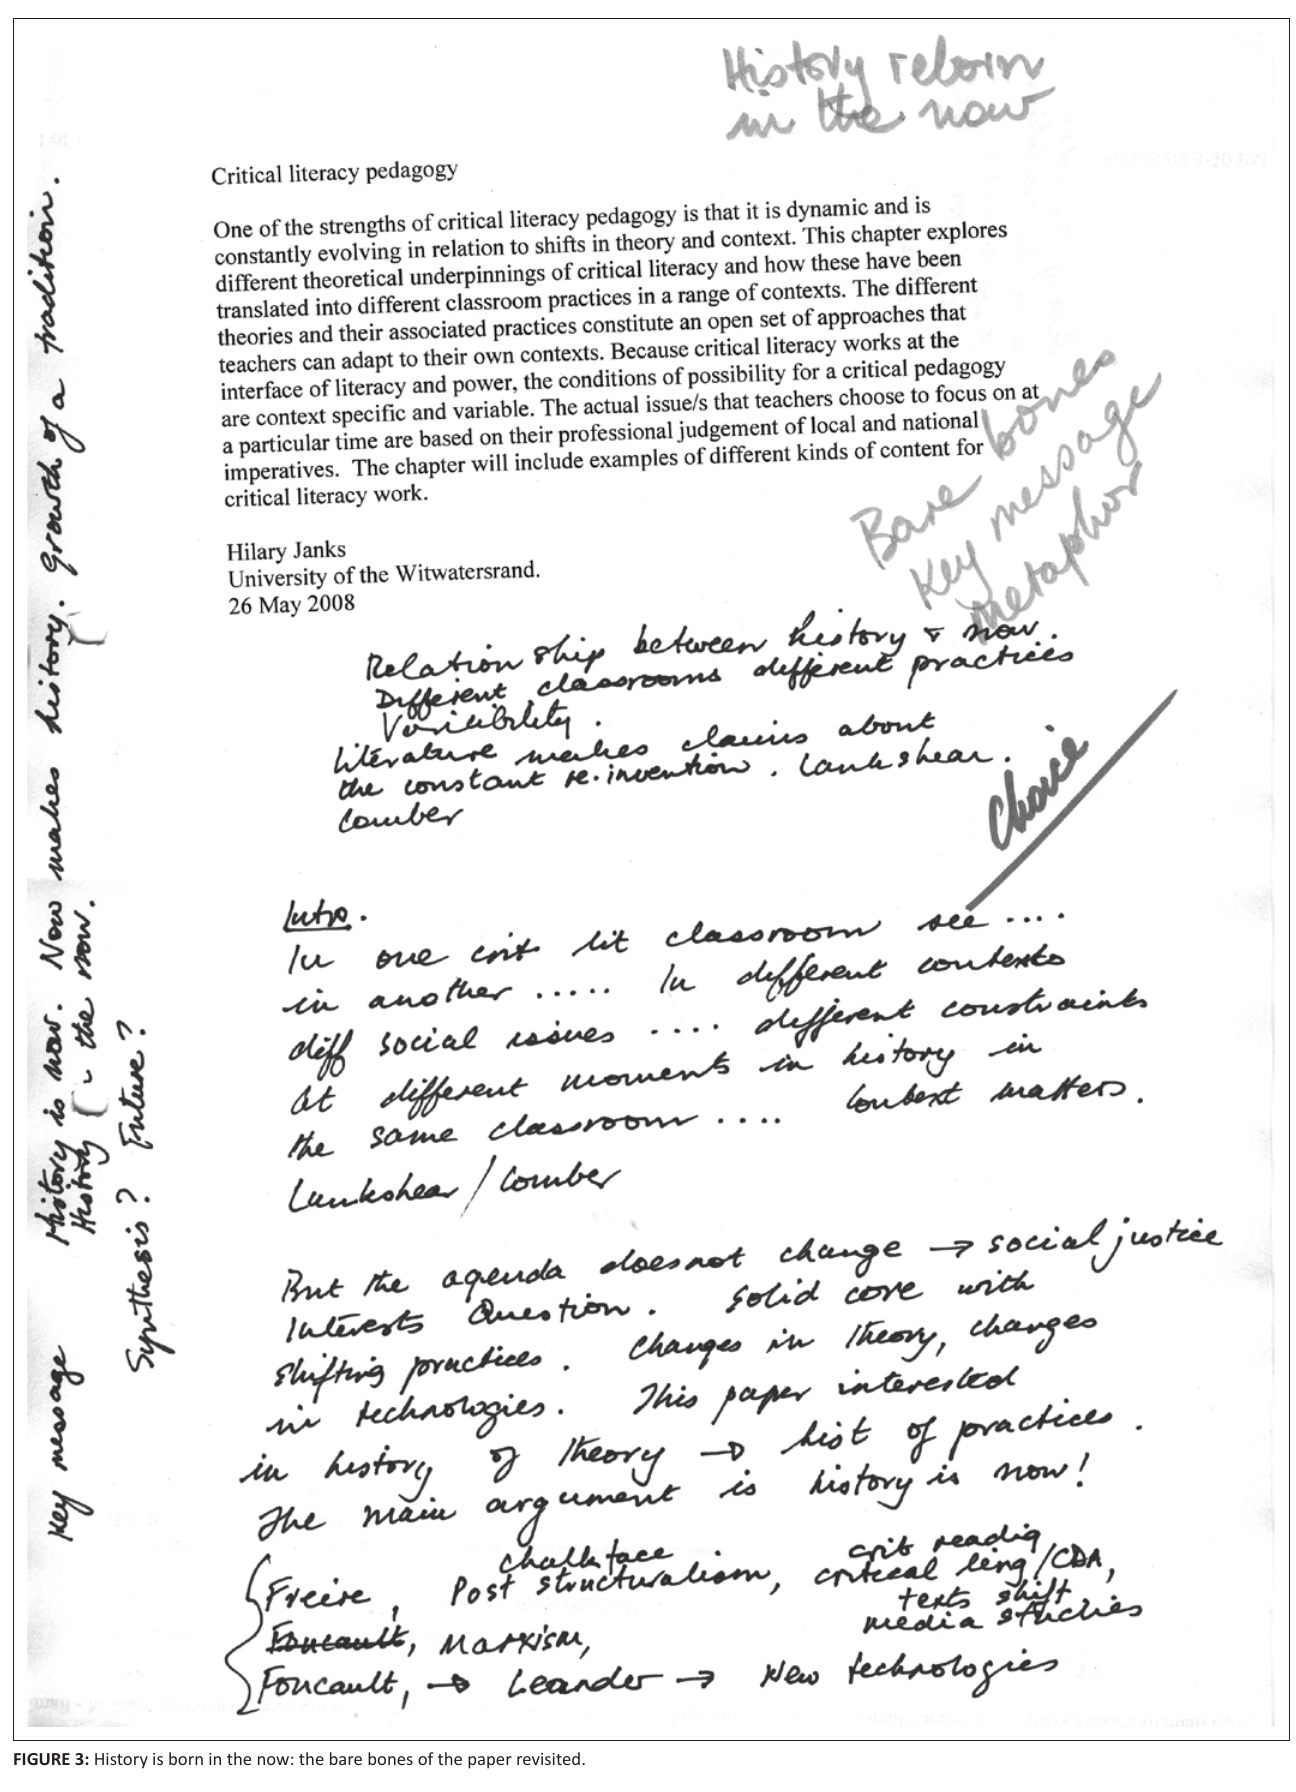
FIGURE 3: History is born in the now: the bare bones of the paper